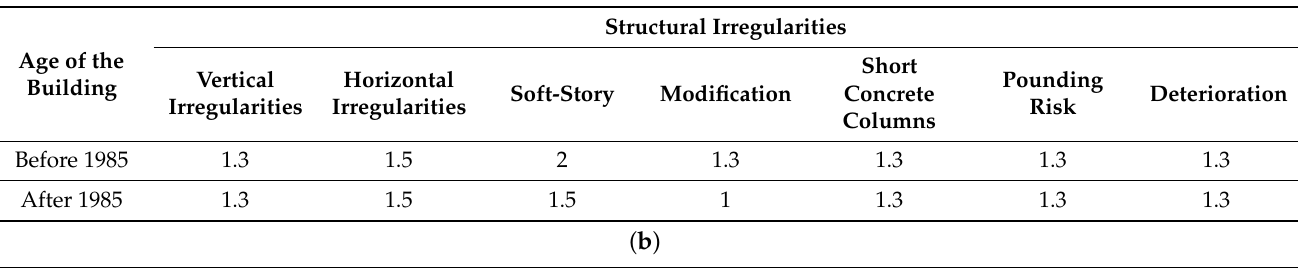
Table 5. Matrix used to determine criterion D (adapted from NRC1992 and NBCC2005). ( a